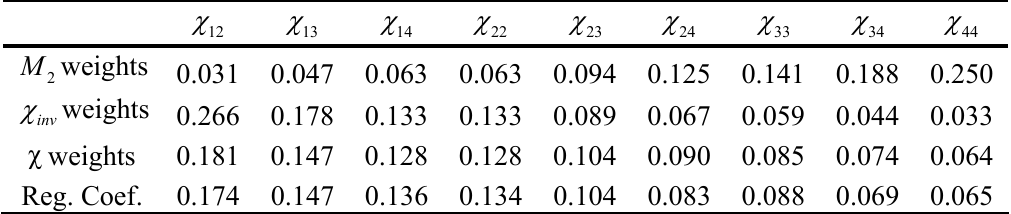
Table 2. Comparison of regression coefficients (Reg. Coef.) and weights assigned by χ , M and χ inv (normalized). 2 χ χ χ χ χ χ χ χ χ 12 13 14 22 23 24 33 34 44 M weights 0.031 0.047 0.063 0.250 2 χ weights inv